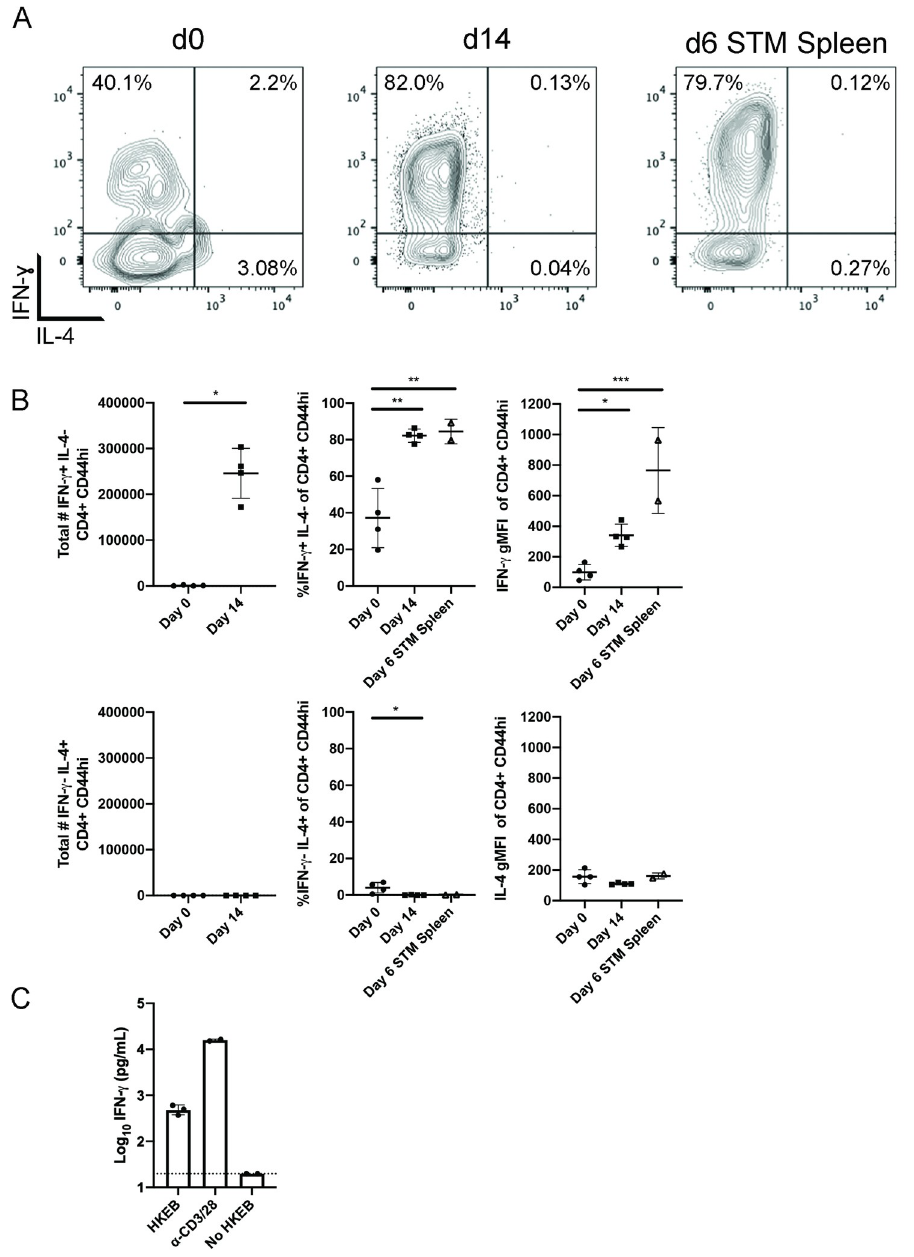
Fig 1. CD4 T cells respond during primary FRT infection in wild-type mice and have a strong IFN- γ signature. Mice either received 2.5mg Depo-Provera 7 days before infection with 1x10 5 IFU Chlamydia muridarum i.vag. or 5x10 5 CFU Salmonella i.v. Lymphocytes were isolated from the FRT on day 14 post infection for Chlamydia -infected mice or from the spleen day 6 post Salmonella infection and stimulated with PMA/ionomycin in the presence of Brefeldin A before staining for flow cytometry. n = 4 for na ï ve and Chlamydia groups, n = 2 for Salmonella group. (A) Example flow cytometry plots of IFN- γ and IL-4 expression gated on CD4+ CD44 hi cells. (B) Summary of flow analysis. (C) IFN- γ ELISA results for CD4 T cells isolated from the FRT of Chalmydia infected mice 15 days post infection and stimulated with HKEBs (Heat-Killed Elementary Bodies), controls stimulated with α -CD3 and α -CD28, or controls that did not receive HKEBs. n = 3 for HKEB stimulation and n = 2 for control groups due to low cell recovery from the third FRT. Results (B and C) are shown as mean +/- SD.